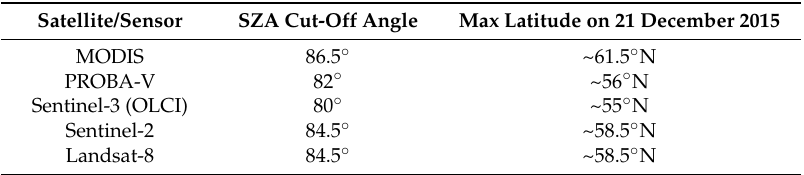
Table 2. Maximum Sun Zenith Angle cut-off for optical heliosynchronous satellites with systematic global coverage.